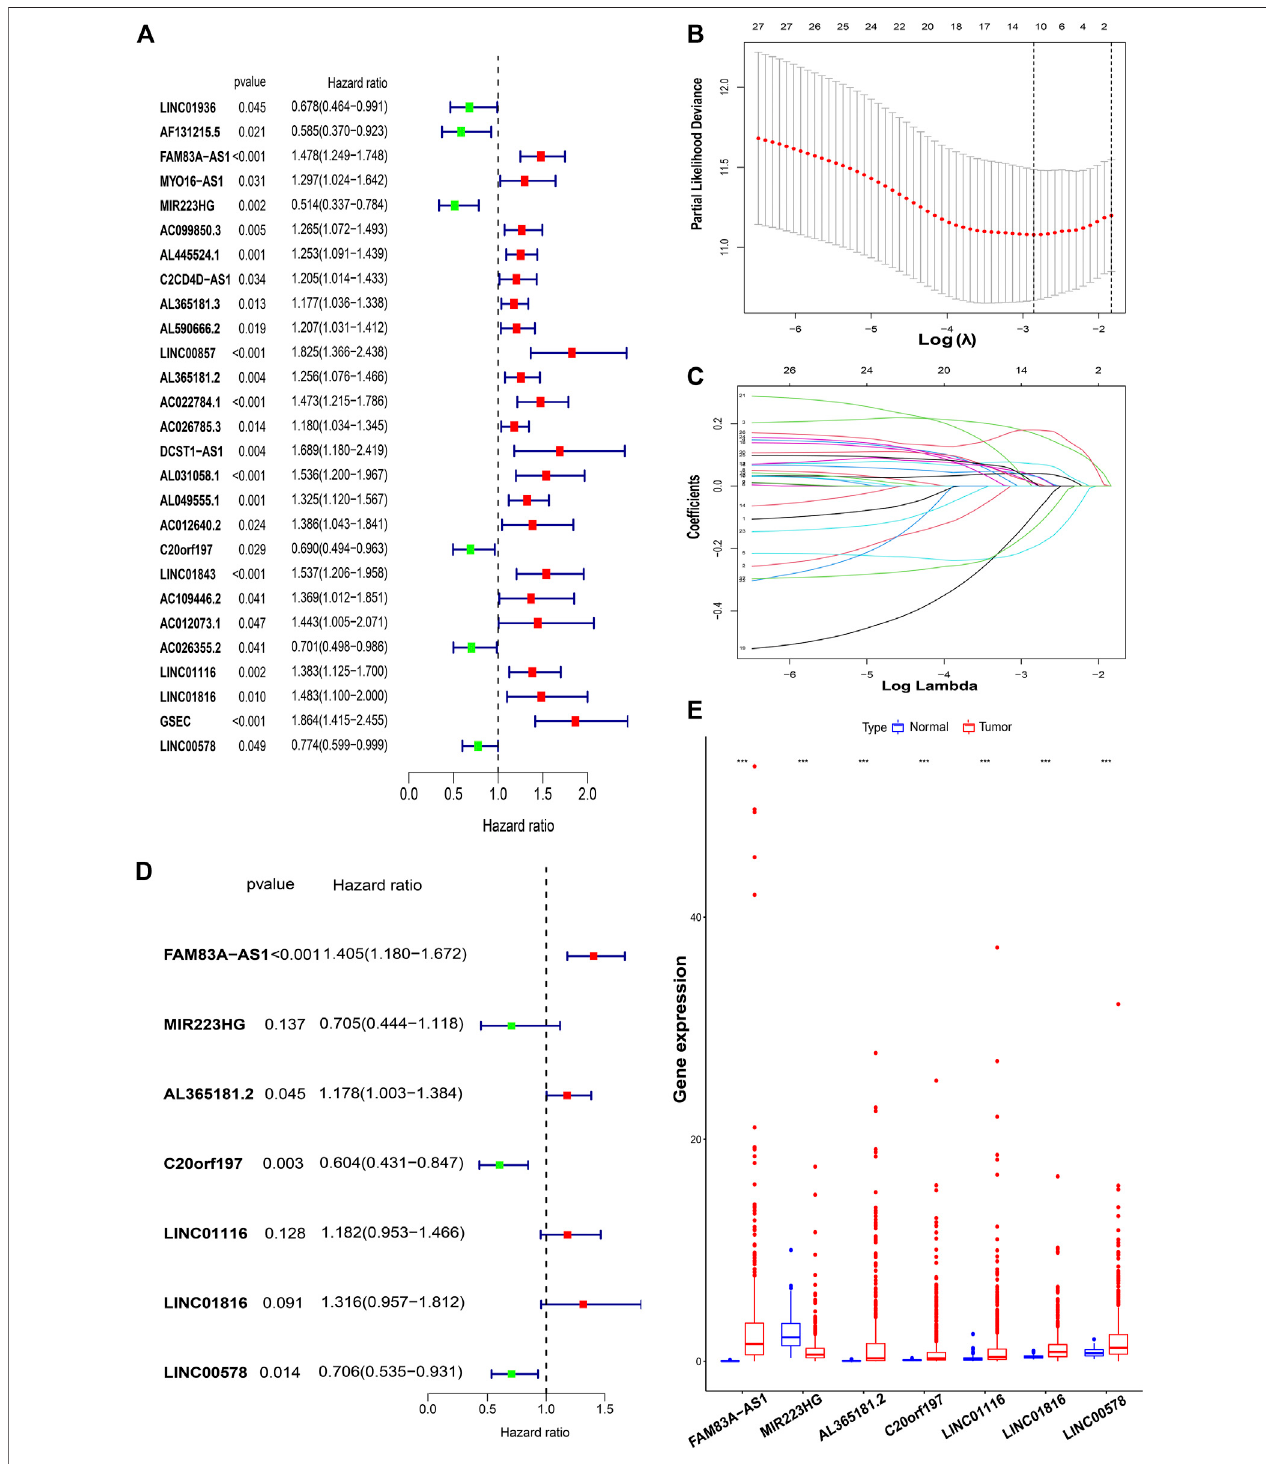
FIGURE 2 | Construction of a risk model for FAM-related lncRNAs in LUAD patients. (A) Univariate Cox regression analysis of FAM-related lncRNAs signi fi cantly associated with clinical prognosis. (B and C) LASSO-Cox regression algorithm was applied to select genes based on minimum criteria to construct risk signatures. (D) Multivariate Cox regression analysis of independent prognostic factors. (E) These seven lncRNAs were signi fi cantly differentially expressed between normal tissues and tumor tissues. ***, p < 0.001.